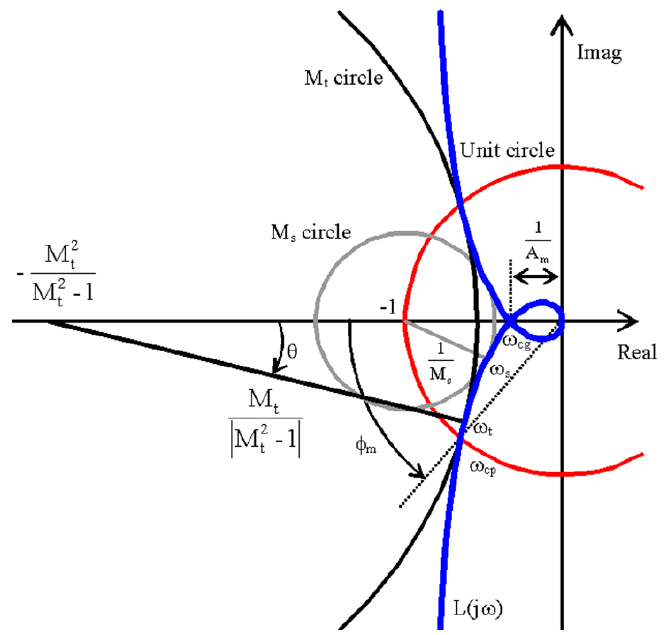
Figure 2. Example of Nyquist plot of the loop transfer function and its features.